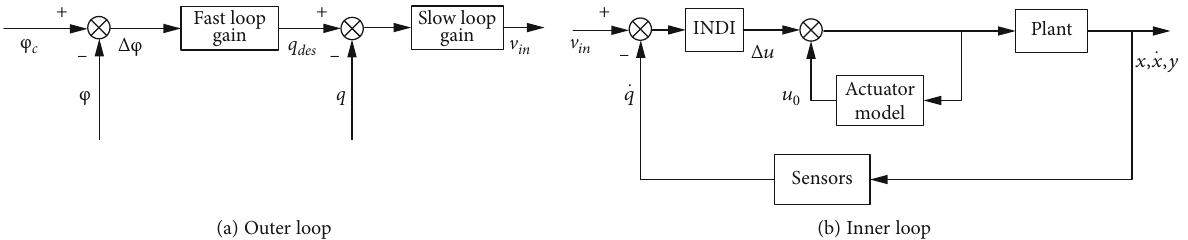
Figure 5: Control block diagram of the (a) outer loop and (b) inner loop.